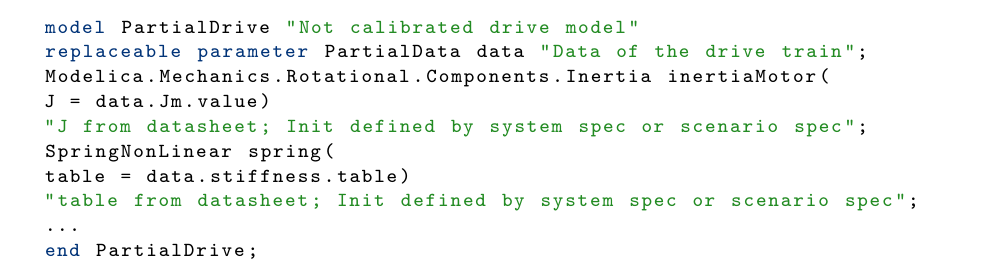
table = data.stiffness.table) "table from datasheet; Init defined by system spec or scenario